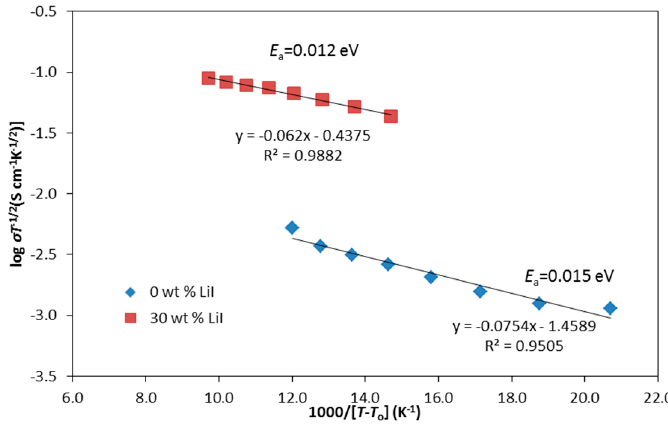
Figure 6. VTF plots for CMKC/CMCE-LiI films.